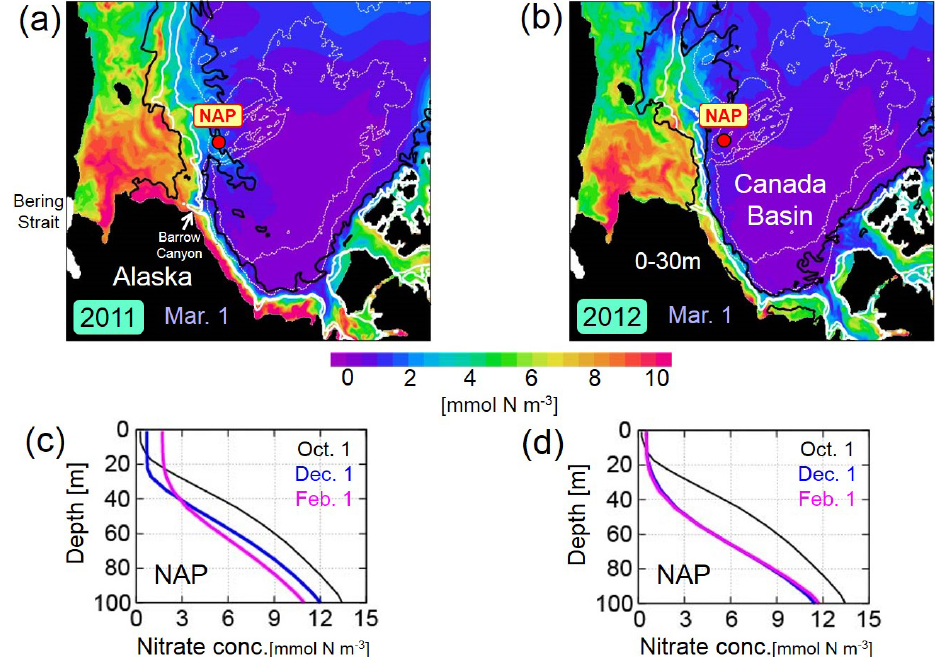
Figure 11. Modeled nitrate concentration (mmolNm − 3 ) . The daily mean fields averaged in the top 30m of water columns on 1 March in the (a) 2011 and (b) 2012 cases are shown in the upper panels. In these experiments, a passive tracer is provided from the ocean surface to sea floor of 100–200m depth along shelf–basin boundary sandwiched by thick white contours. Black contours correspond to a tracer value of 0.2 (0–30m average). Thin white contours denote the isobaths of 1000 and 3000m. The vertical profile in the NAP region on (black) 1 October, (blue) 1 December and (magenta) 1 February in the (c) 2011 and (d) 2012 cases are shown in the lower